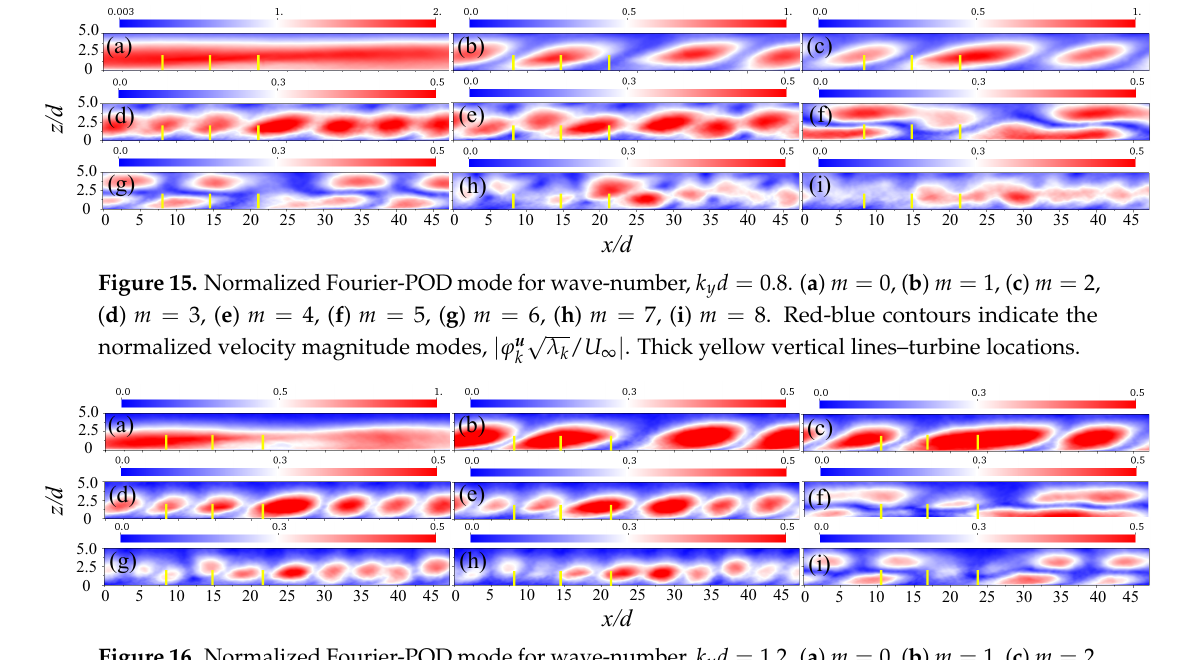
Figure 16. Normalized Fourier-POD mode for wave-number, k y d = 1.2. ( a ) m = 0, ( b ) m = 1, ( c ) m = 2, ( d ) m = 3, ( e ) m = 4, ( f ) m = 5, ( g ) m = 6, ( h ) m = 7, ( i ) m = 8. Red-blue contours indicate the normalized velocity magnitude modes,